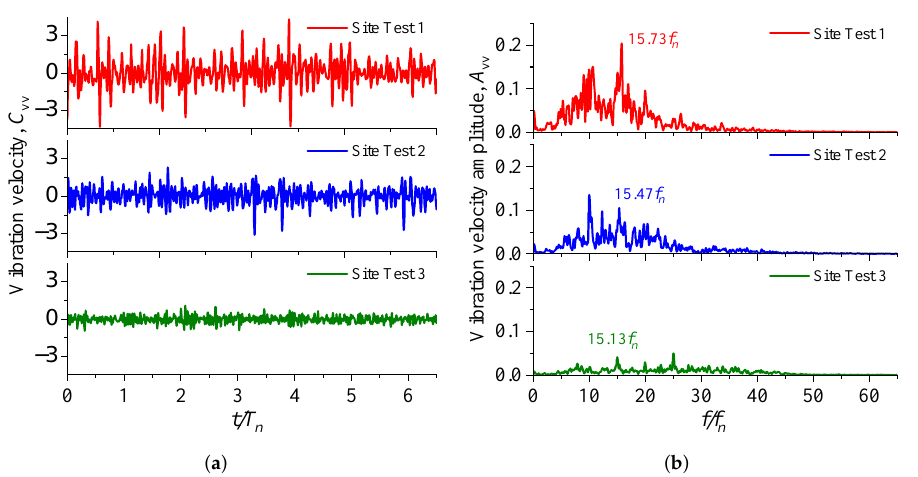
Figure 18. The horizontal vibration velocities of the guide vane blade in site tests: ( a ) the time histories of the vibration velocities, where T n is the runner rotating period; ( b ) the amplitudes of the vibration velocities, where f n is the runner rotating